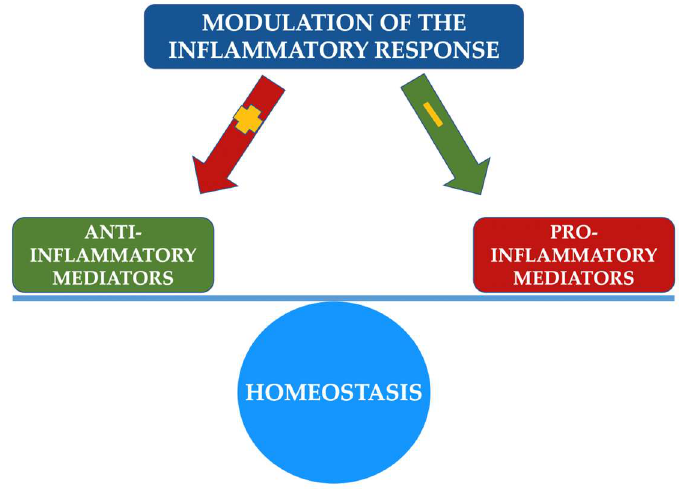
Figure 2. Synthesis of host inflammatory response therapy action pathways.